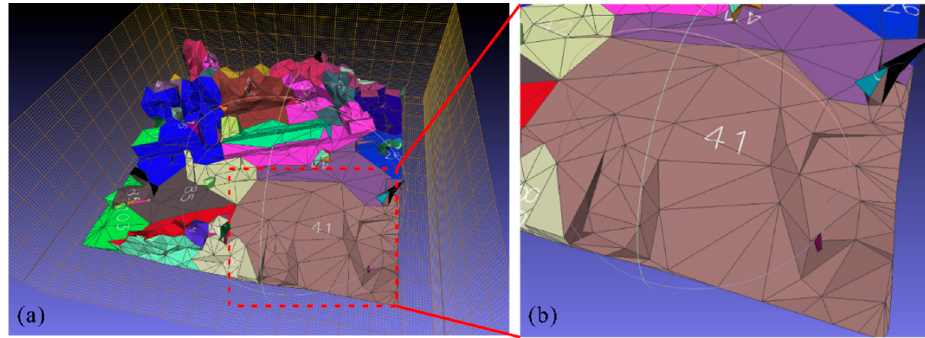
Figure 7. Best view IDs of the original mesh facets: ( a ) whole drawing; ( b ) partial enlarged drawing.